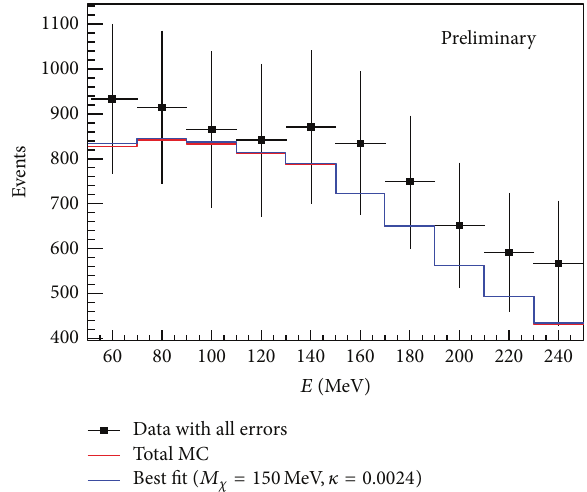
Figure 13: (Color online) The dark matter fit result to the NCE data [116].